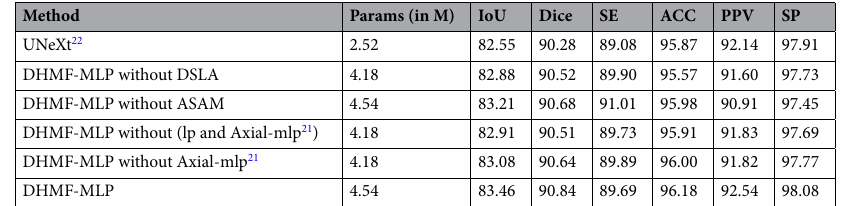
Table 5. Ablation studies of the proposed blocks on the ISIC 2018 dataset.